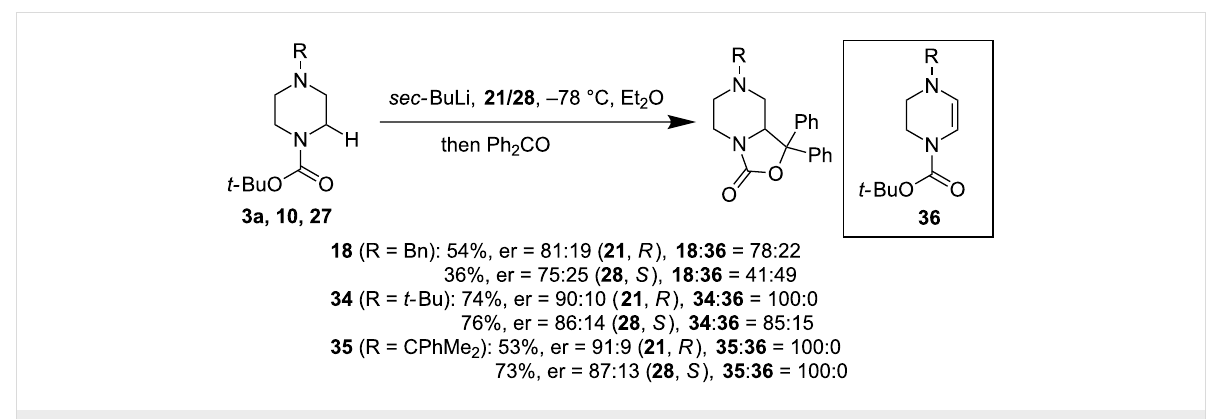
Figure 9: Asymmetric α -functionalization of N -Boc-piperazines with Ph 2 CO by O’Brien et al. in 2016